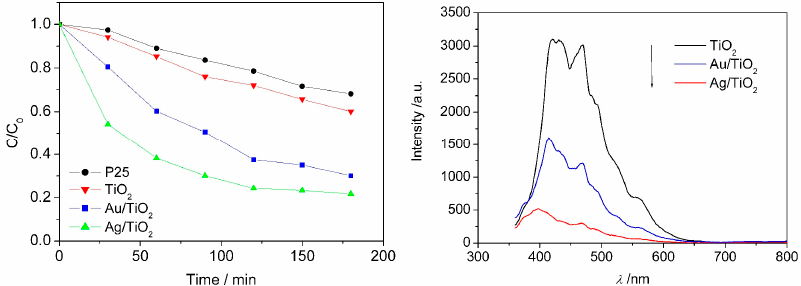
Figure 16. Photodegradation curves of MB (methyl blue) in the presence of P25, TiO 2 , Au/TiO 2 and Ag/TiO 2 ( left ); Photoluminence spectra ( λ ex = 215 nm) of pure urchin-like TiO 2 , Au/TiO 2 and Ag/TiO 2 ( right ) [31].